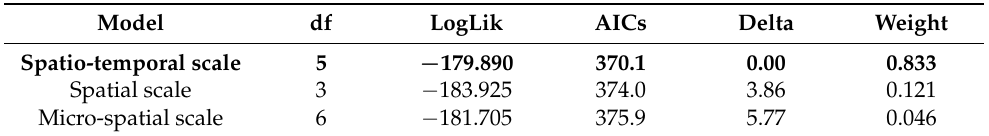
Table 2. Summary of the model selection using estimations based on the calculated AICc value of the models, serving as the weight of evidence in favor of the different models. The most parsimonious model (delta < 2) is emphasized in bold.